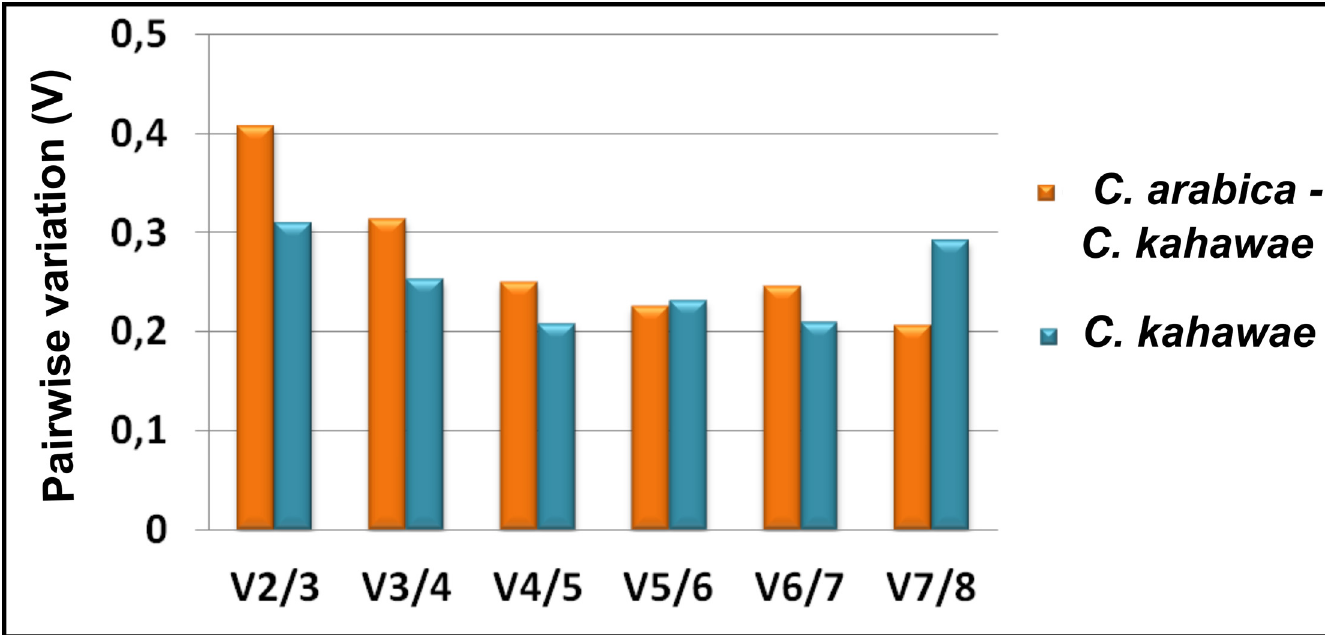
Fig 2. Prediction of the optimal number of reference genes required for effective normalization. Pairwise variation (V) of the candidate reference genes calculated by geNorm using the two different datasets studied: i) all C . arabica-C . kahawae samples; ii) all C . kahawae